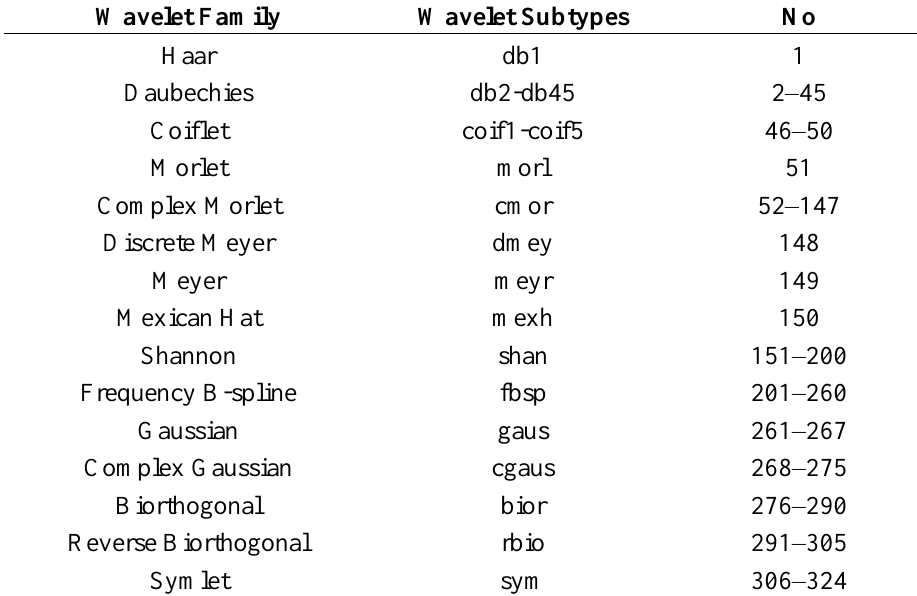
Table 1. List of 324 wavelet functions from 15 wavelet